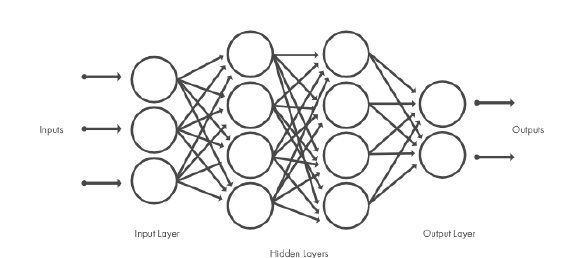
Figure 1: Neural networks, which are organized in layers consisting of a set of interconnected nodes